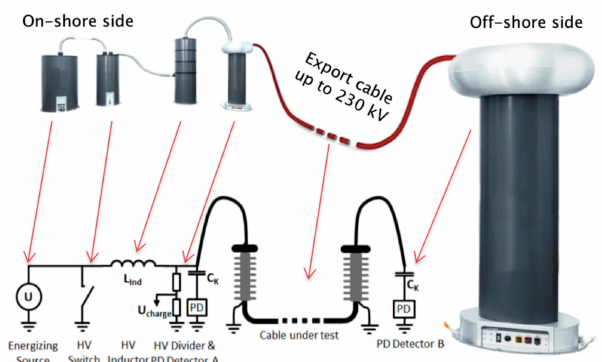
Figure 6. Setup for dual-sided PD monitored on-site testing techniques for o ff shore export cables of long lengths: DAC excitation circuit and synchronized PD detector units supported by PD measurement with localization feasibility with C k the coupling capacitor (1–2 nF), L ind is the air core inductance (5–9